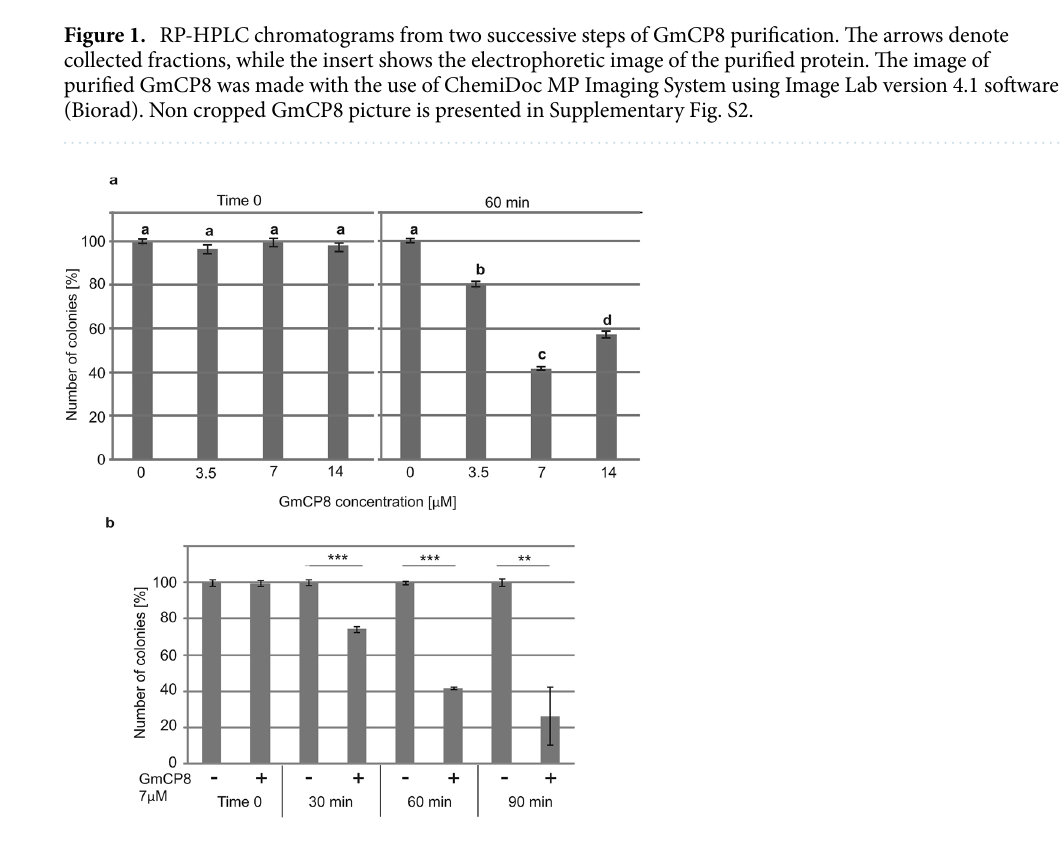
Figure 2. Antimicrobial activity of the GmCP8 peptide against P. entomophila . ( a ) GmCP8 at different final concentrations was mixed with P. entomophila as indicated in the “Materials and methods”. ( b ) GmCP8 at a concentration of 7 µM was incubated with P. entomophila for the indicated time. In the control, an equal amount of water was added instead of GmCP8. The samples were plated directly (time 0) and after the indicated time of incubation. The results are shown as a percentage of CFU grown after incubation with the GmCP8 peptide in relation to the average number of CFU without addition of the peptide at the respective time points. The experiment was performed three times, and data from 2 dilutions were taken for calculations each time. Mean values ± SD are shown. In ( a )—data with different letters show significant difference (One-way ANOVA, Tukey’s test, p < 0.05). In ( b )—significant differences are indicated * p < 0.05, ** p < 0.01, *** p < 0.001 (Student